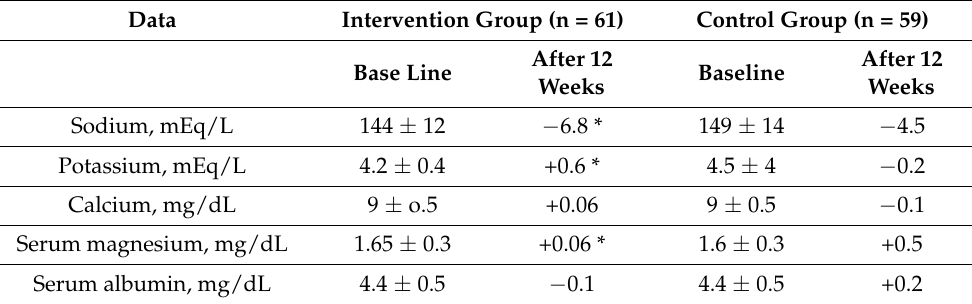
Table 5. Effects of guava fruit intake on macro-minerals related to blood